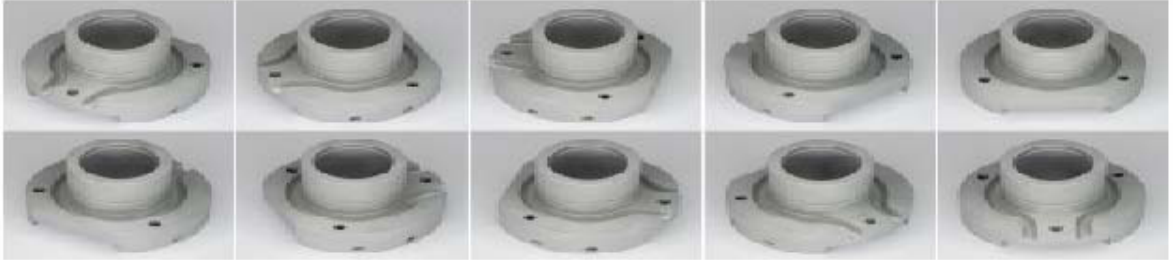
Figure 13. Every ninth image shows an example photo of a single item captured in 4-degree increments. 7. State-of-the-Art Sensors Used in Industry